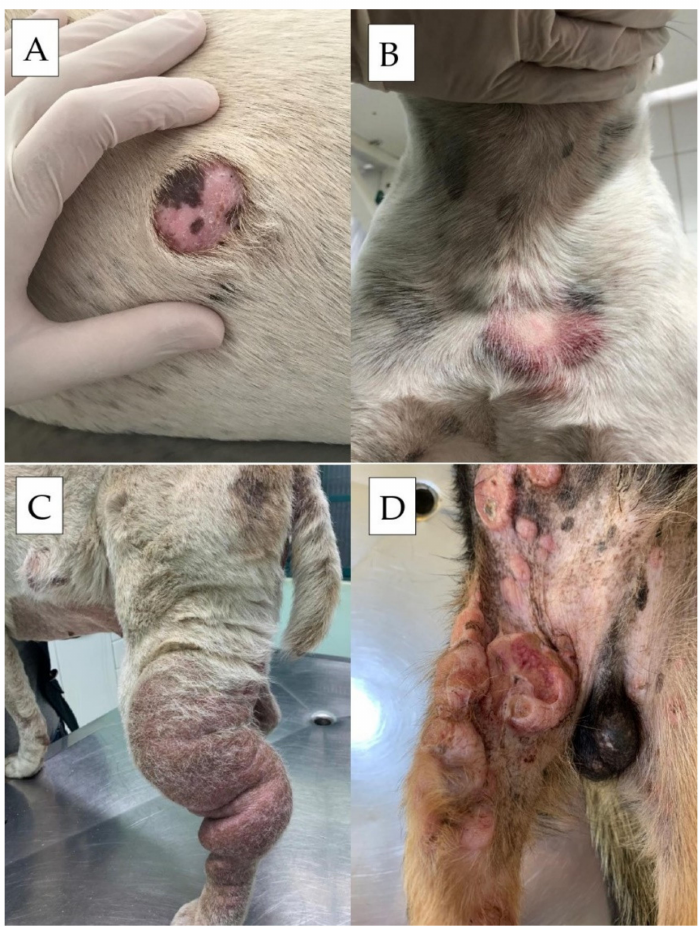
Figure 1. Canine mast cell tumors evidencing different clinical presentations. ( A ) Solitary, well- delimited and alopecic lesion in a dog. ( B ) Solitary irregular erythematous and partially alopecic cutaneous lesion. ( C ) Disseminated lesion with cutaneous/subcutaneous involvement and limb edema. ( D ) Multiple lesions with ulceration